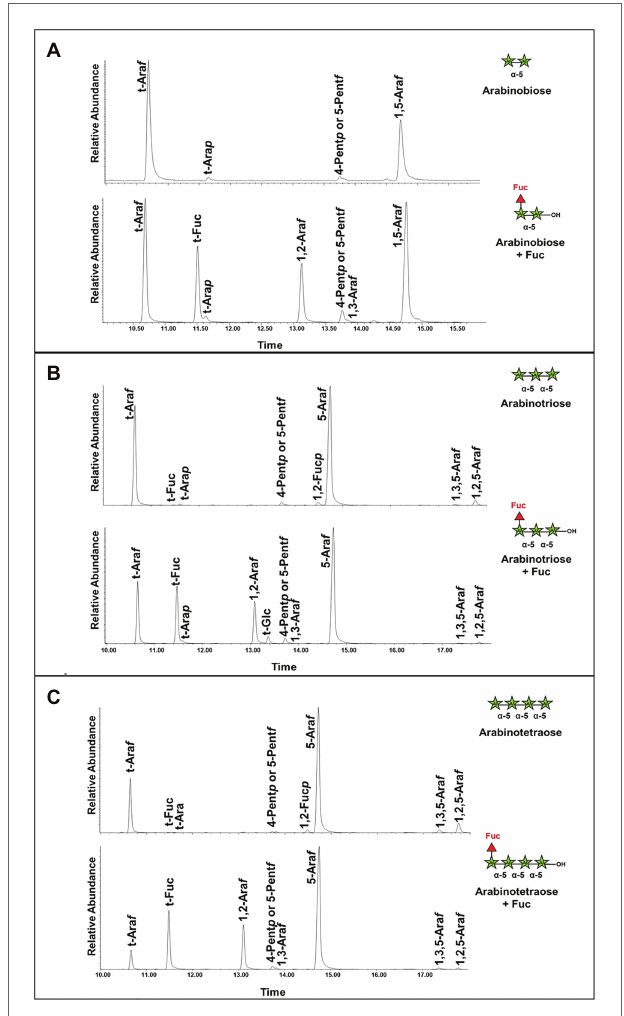
FIGURE 8 | Linkage analysis of the reaction products of arabinan oligosaccharides incubated with GFP- At FUT4. (A) Unreacted arabinobiose and arabinobiose incubated with GFP- At FUT4. (B) Unreacted arabinotriose and arabinotriose incubated with GFP- At FUT4. (C) Unreacted arabinotetraose and arabinotetraose incubated with GFP- At FUT4. The presence of the 1,2-Ara f peak in the spectra of the reaction products indicates that Fuc is attached to the terminal non-reducing Ara in all the oligosaccharides. As the 1,3,5-Ara f and the 1,2,5-Ara f peaks appear in the unreacted and reacted spectra we do not ascribe these to transfer in those